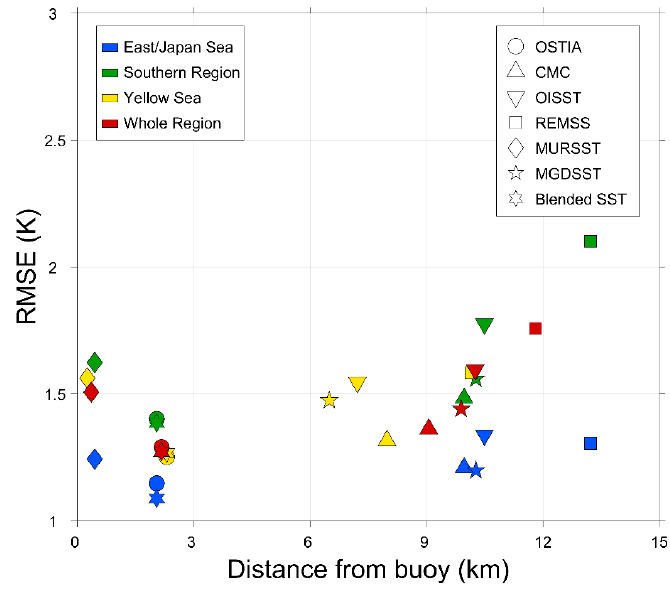
Figure 7. Scatter plot of root-mean-squared error (RMSE) of sea surface temperature analysis as a function of distance between the center of grid cell of SST analyses and the position of coastal wave buoys in the East/Japan Sea, southern region of the Korean Peninsula, Yellow Sea, and for the region as a whole.